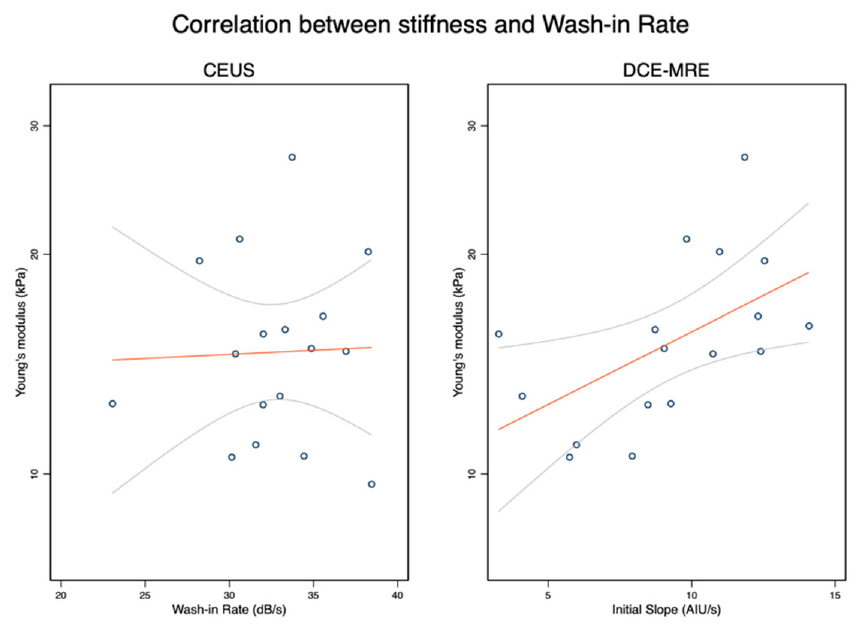
Figure 4. The stiffness of small intestinal strictures is associated with the initial slope of Dynamic Contrast-Enhanced MR Enterography (DCE-MRE) ( right ), spearman’s ρ = 0.63, p = 0.007, but not with wash-in rate of Contrast-Enhanced Ultrasonography (CEUS) ( left ), spearman’s ρ = 0.08, p = 0.76.